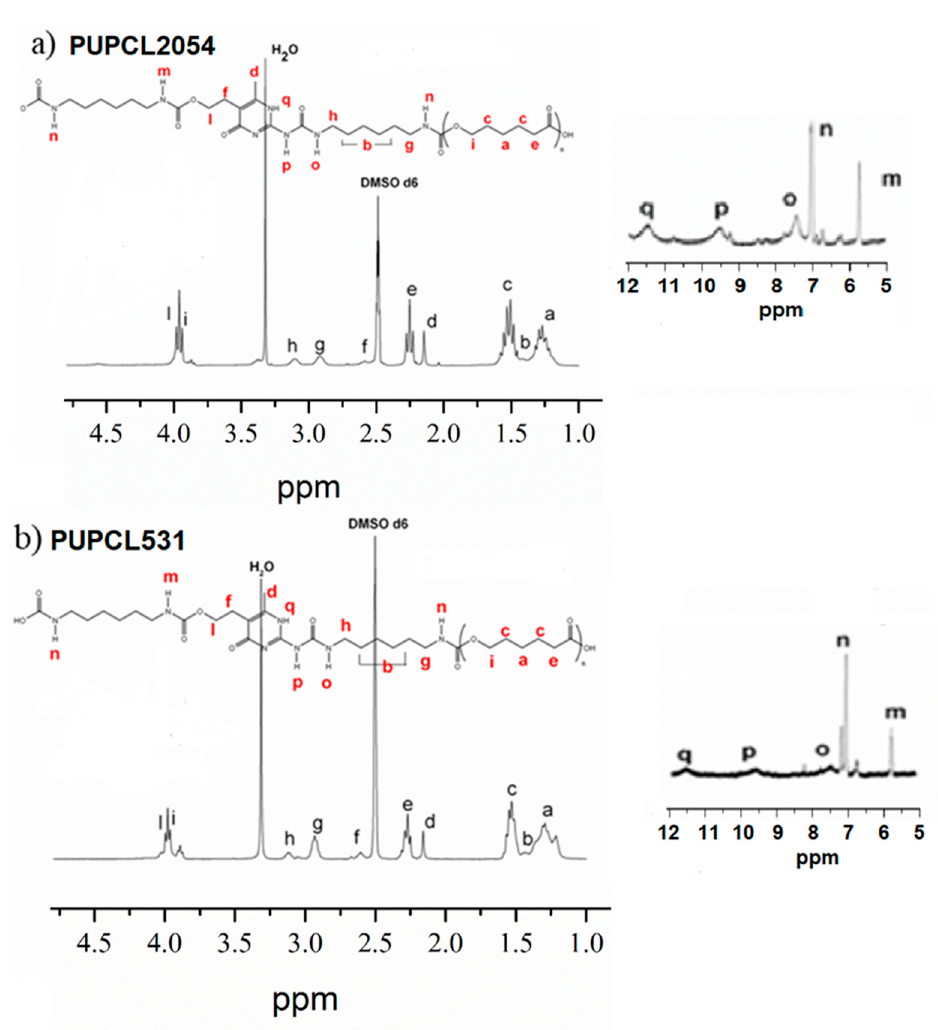
Figure 2. 1 H NMR spectra of ( a ) PUPCL2054 and ( b ) PUPCL531 in DMSO d 6 . For PUPCL2054, the characteristic peaks attributed to the UPy urea and urethane groups appeared at 11.53 ppm ( δ H q ), 9.59 ppm ( δ H p ), 7.47 ppm ( δ H o ), 6.95 ppm ( δ H n ) and 5.72 ppm ( δ H m ). Meanwhile, the characteristic peaks of the methylene groups in the PCL backbone appeared at 3.87 ppm ( δ H i ), 2.26 ppm ( δ H e ), 1,52 ppm ( δ H c ) and 1.20 ppm ( δ H a ). Regarding PUCL531, the characteristic signals attributed to the UPy urea and urethane groups appeared at 11.55ppm ( δ H q ), 9.54 ppm ( δ H p ), 7.45 ppm ( δ H o ), 7.00 ( δ H n ) and 5.71 ppm ( δ H q ). NMR measurements confirmed the presence of UPy N-H signals (signals q, p and o) [22].